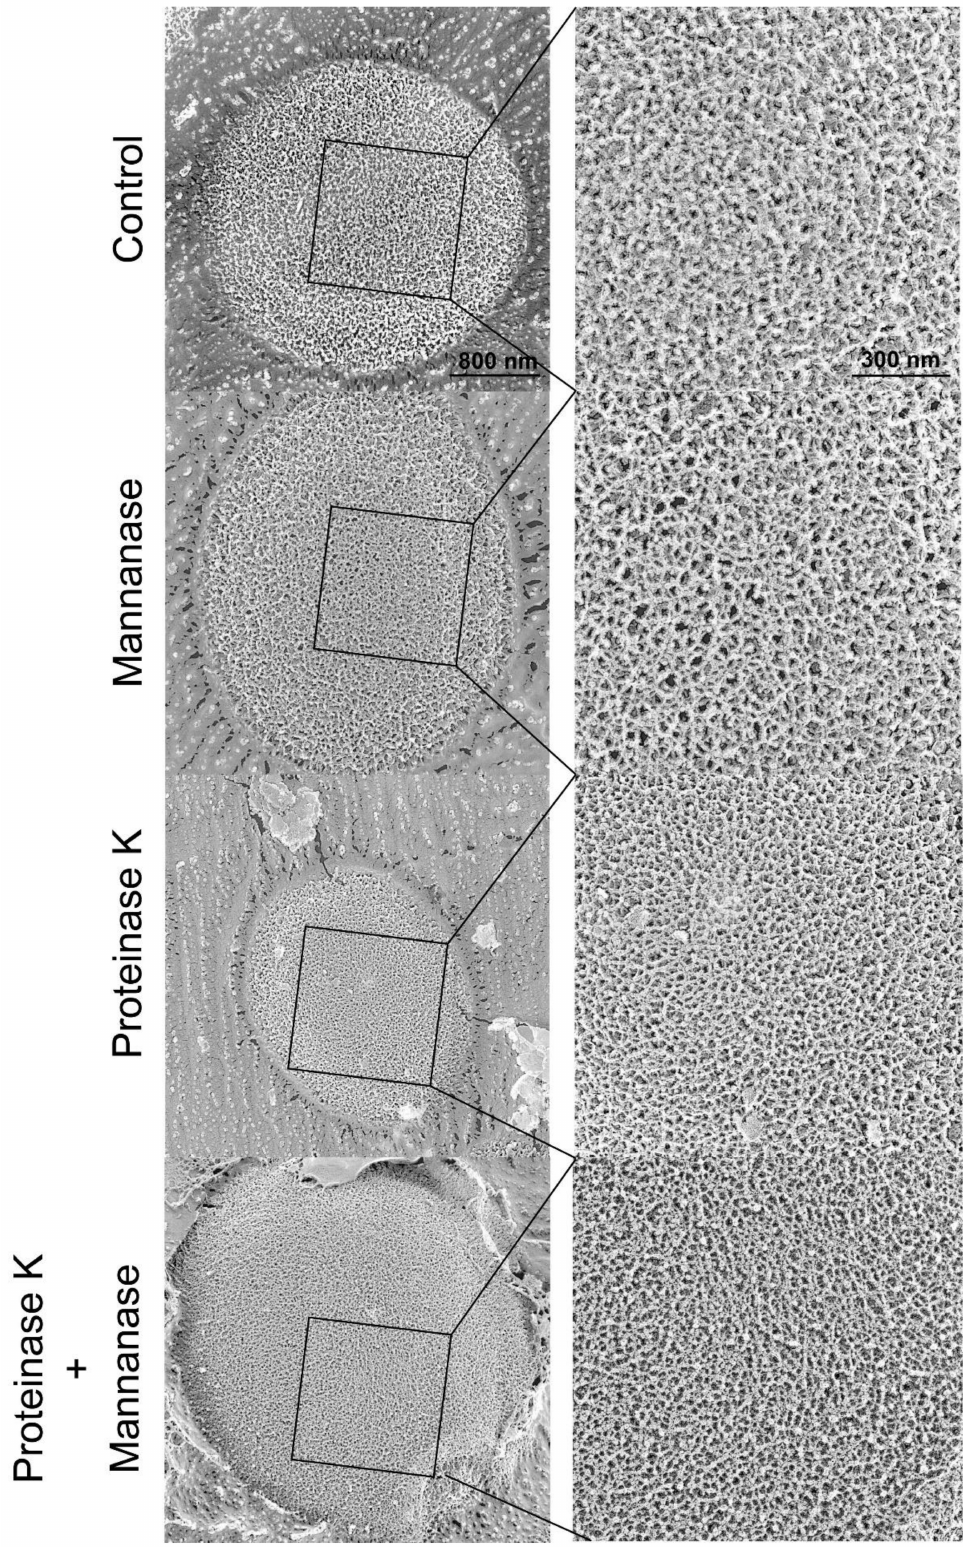
Figure 8. The surface of yeast cells treated with mannanase and/or proteinase K in field and magnified images. Exponentially growing cells were treated with mannanase and/or proteinase K at 37 ◦ C for 30